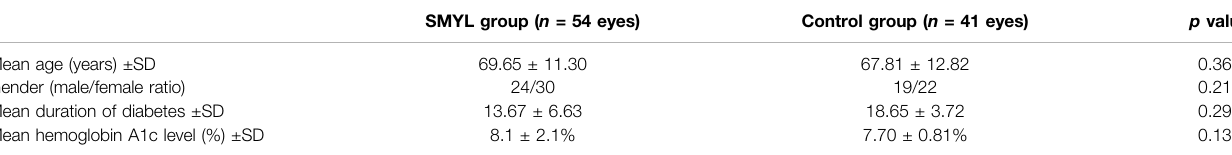
TABLE 1 | Demographics and clinical characteristics of the SMYL and control group at baseline.